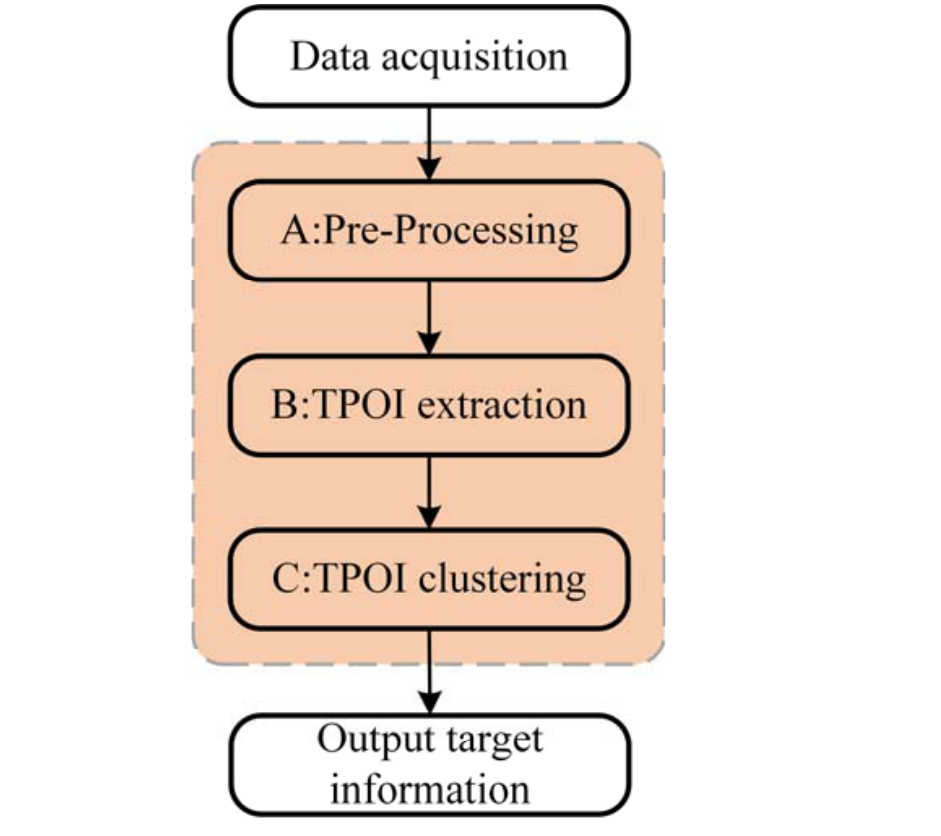
Figure 1. Flowchart of the proposed